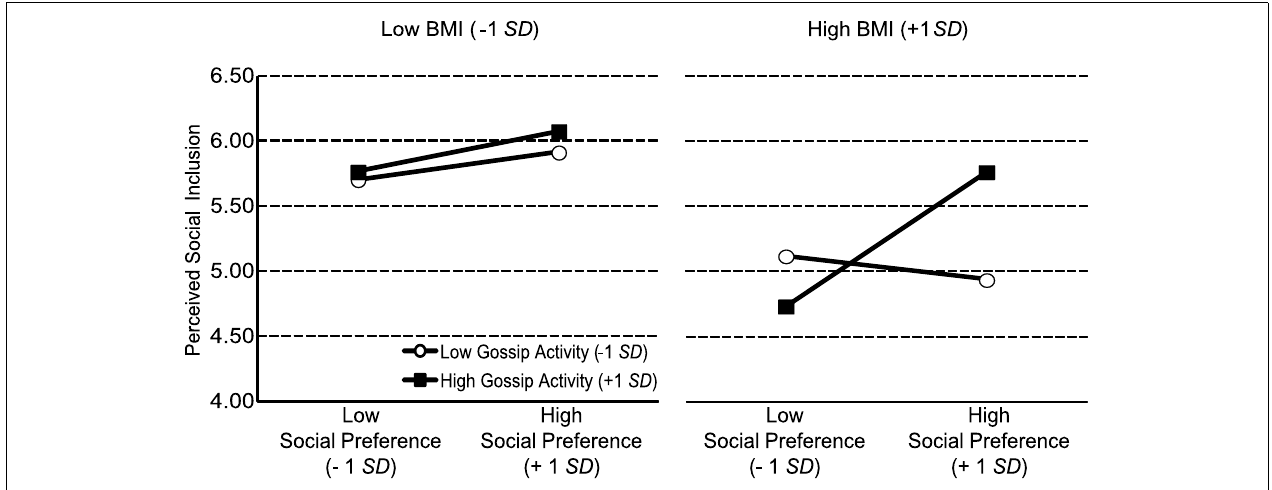
FIGURE 1 | Relationship between perceived social inclusion, Body Mass Index (BMI), social preference, and gossip